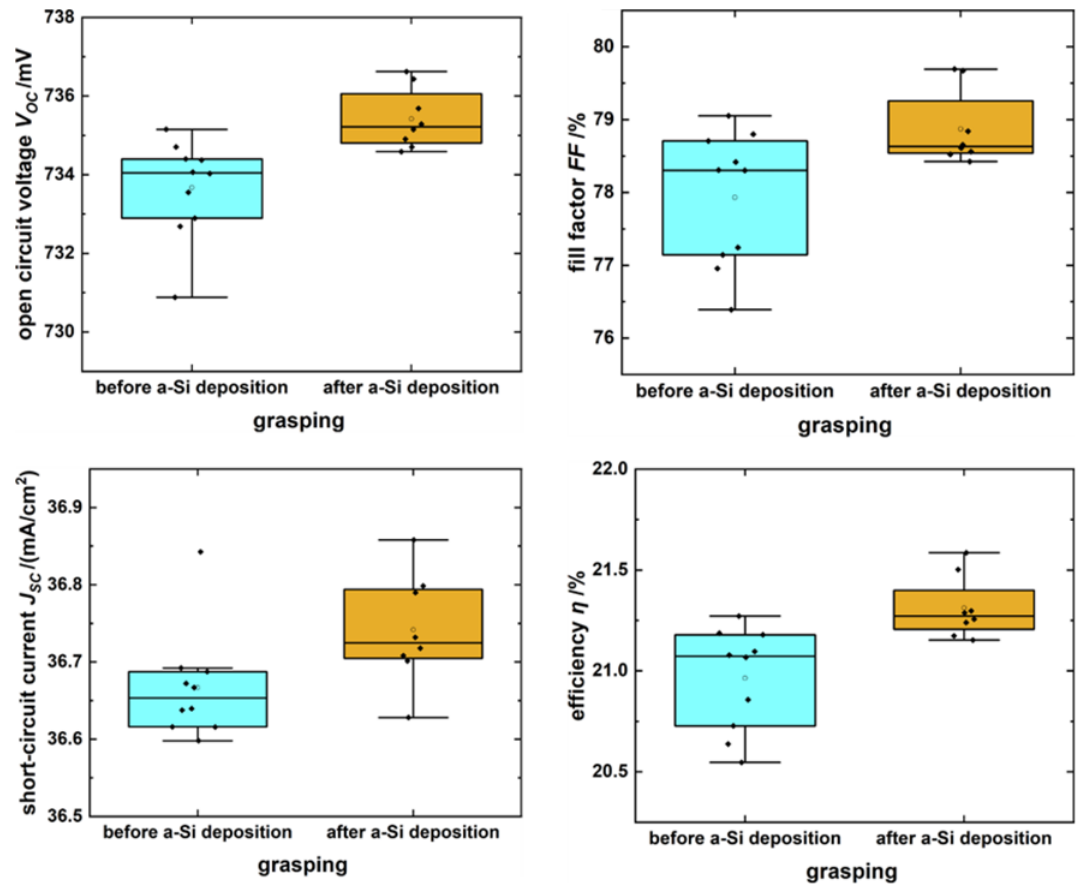
Fig. 5. Results for cell parameters of cells handled before or after